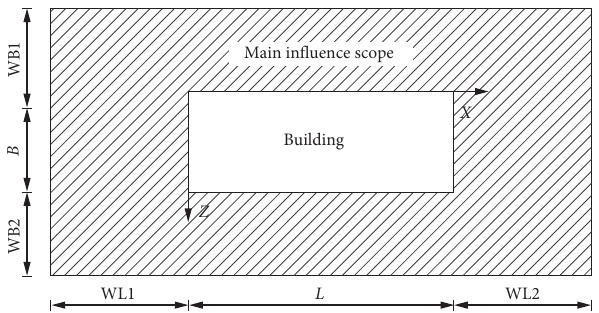
Figure 10: Main influence scope of debris accumulation of the collapsed building